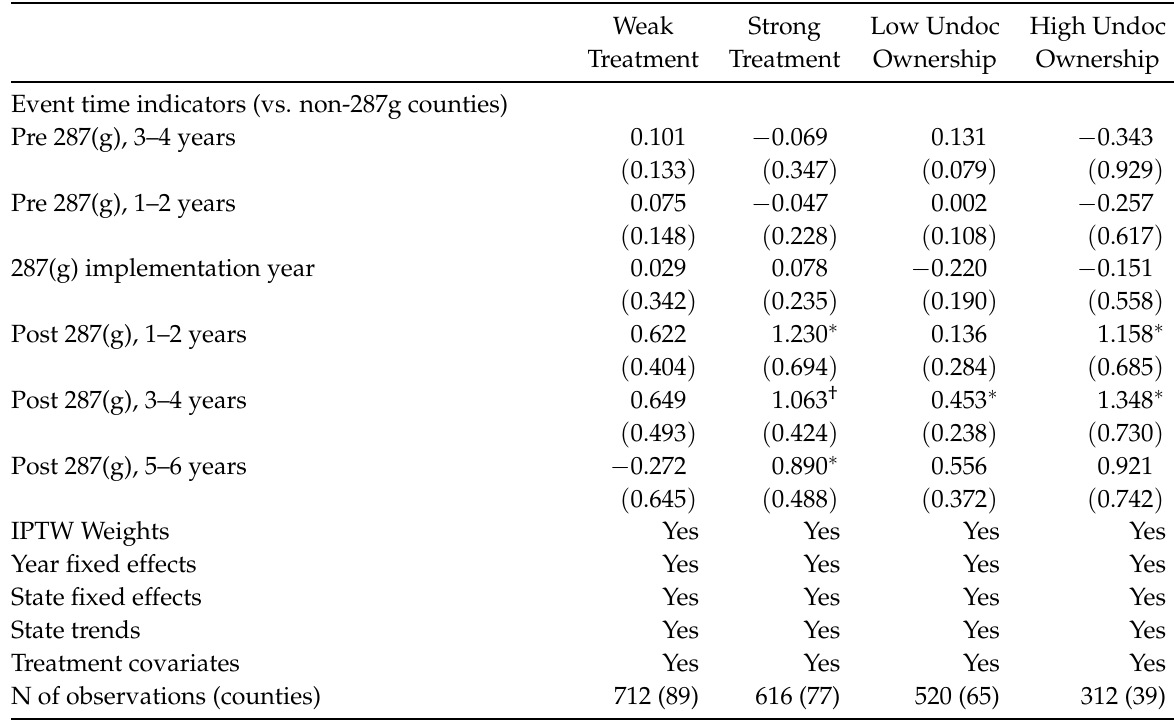
Table 4: Difference-in-difference estimates of 287(g) participation on county Hispanic foreclosure rates (2005– 2012) among 287(g) applicant